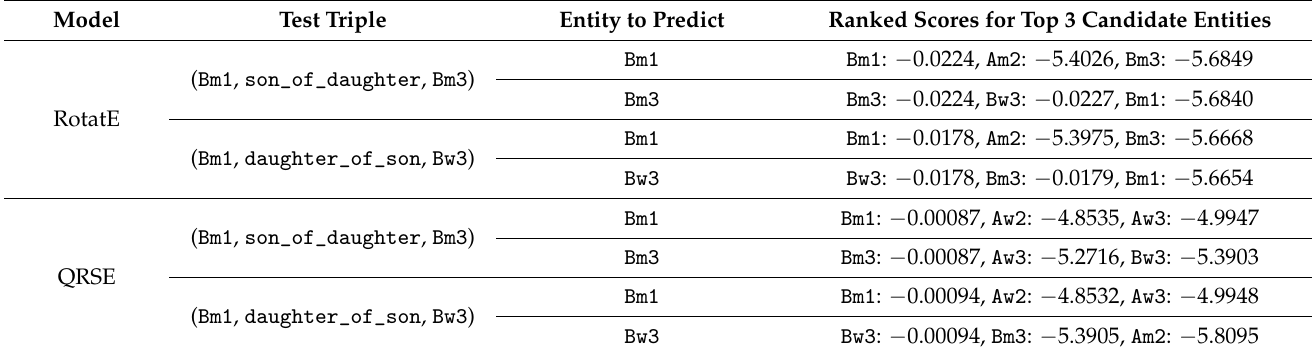
Table 3. The detailed test results of RotatE and QRSE at training step